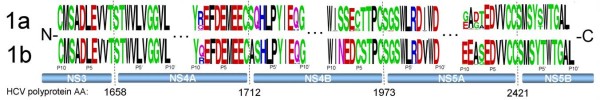
Baseline conservation of cleavage sites. Sequence logos (Schnieder ref
[18], Crooks ref
[19]) were generated from baseline (pre-treatment) HCV sequence. Dashed lines indicate cleavage points along the HCV polyprotein, with the amino acid numbering below the cleavage site referencing HCV genotype 1a reference strain H77 (Genbank accession NC_004102). Cartoons of proteins are not drawn to scale. (Sample size for each sequence logo— NS3-NS4A and NS4A-NS4B: 1a = 327 patients, 1b = 242 patients; NS4B-NS5A and NS5A-NS5B: 1a = 219 patients, 1b = 108 patients).